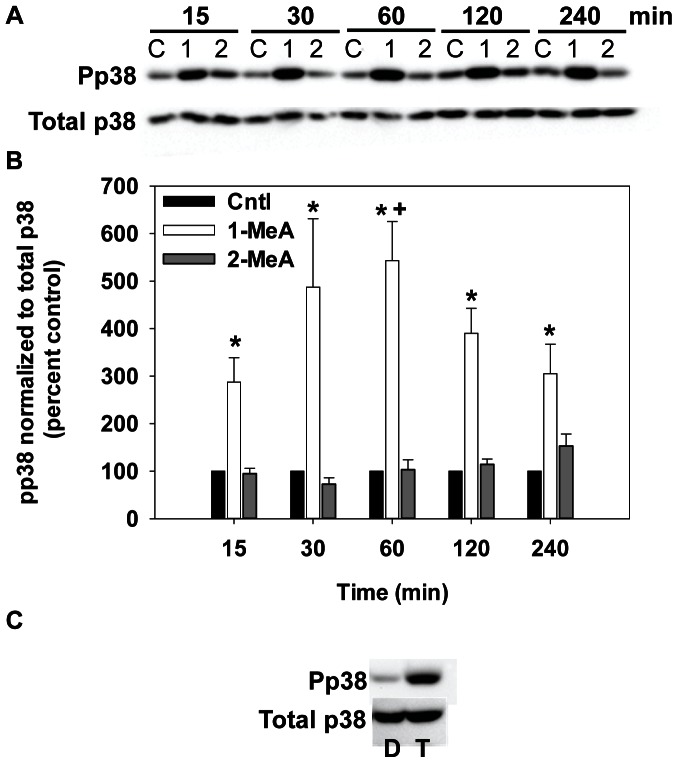
PhosphopP38 (pP38) MAPK activation following treatment with 1- but not 2- MeA.(A) Immunoblot for pP38 and total p38 for 15 min to 4 h of treatment. (B) Densitometric analysis of pP38 normalized to total P38, represented as percent control. Concentrations used: 75 µM 1-MeA and 75 µM 2-MeA. Mean ± SEM presented with n = 3 per study, replicated 3 times. 1-MeA, 1-methylanthracene; 2-MeA, 2-methylanthracene; Cntl, CH3CN vehicle control. *p<0.05 compared to control; +p<0.05 compared to 2-MeA treated cells at the same time point. (C) Positive control using T, TPA (50 nM, 60 min) or D, DMSO (negative control) for activation of P38.